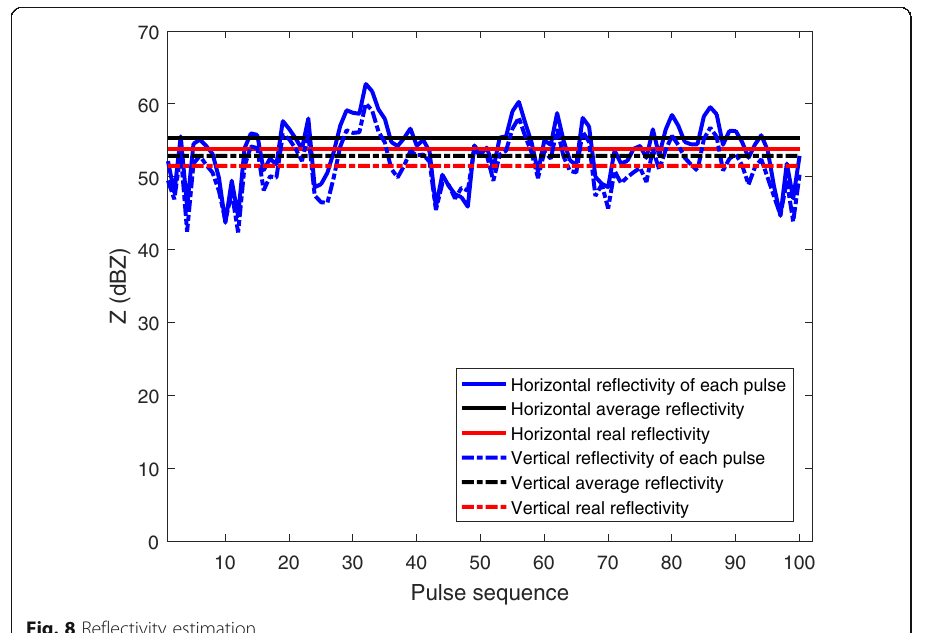
Fig. 8 Reflectivity